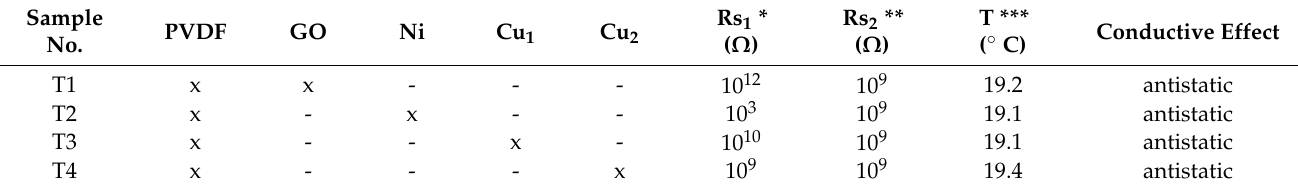
Table 2. Electrical properties of the electrodes before and after treatments with artificial (alkaline/acid)